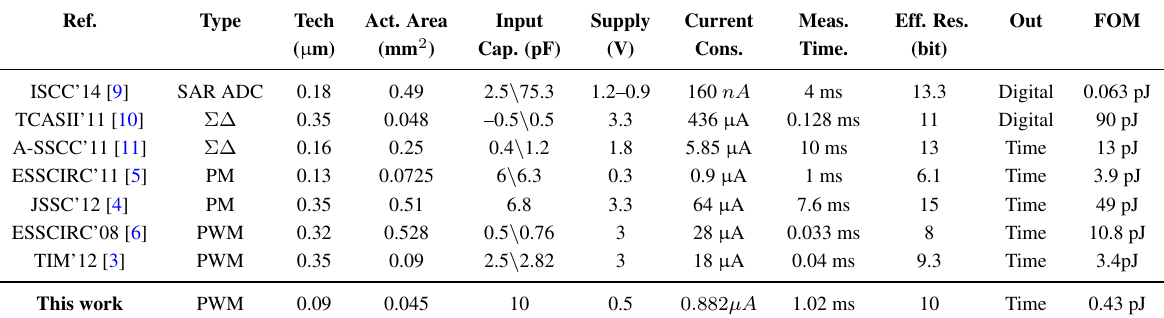
Table 1. Comparison of reported capacitive sensor